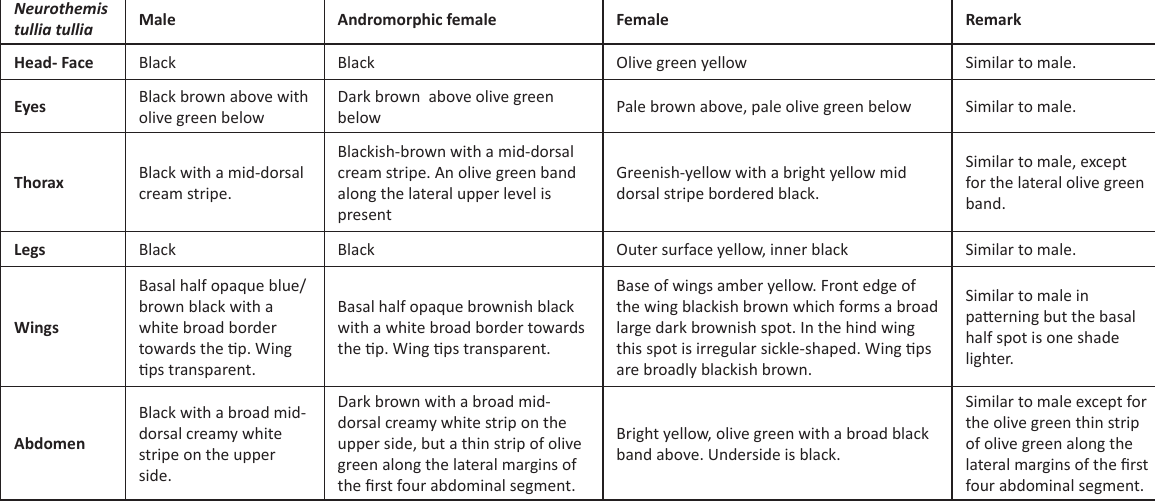
Table 1. Comparison of the colour and wingspot pattern of andromorphic female with normal male and female of Neurothemis t. tullia Neurothemis tullia